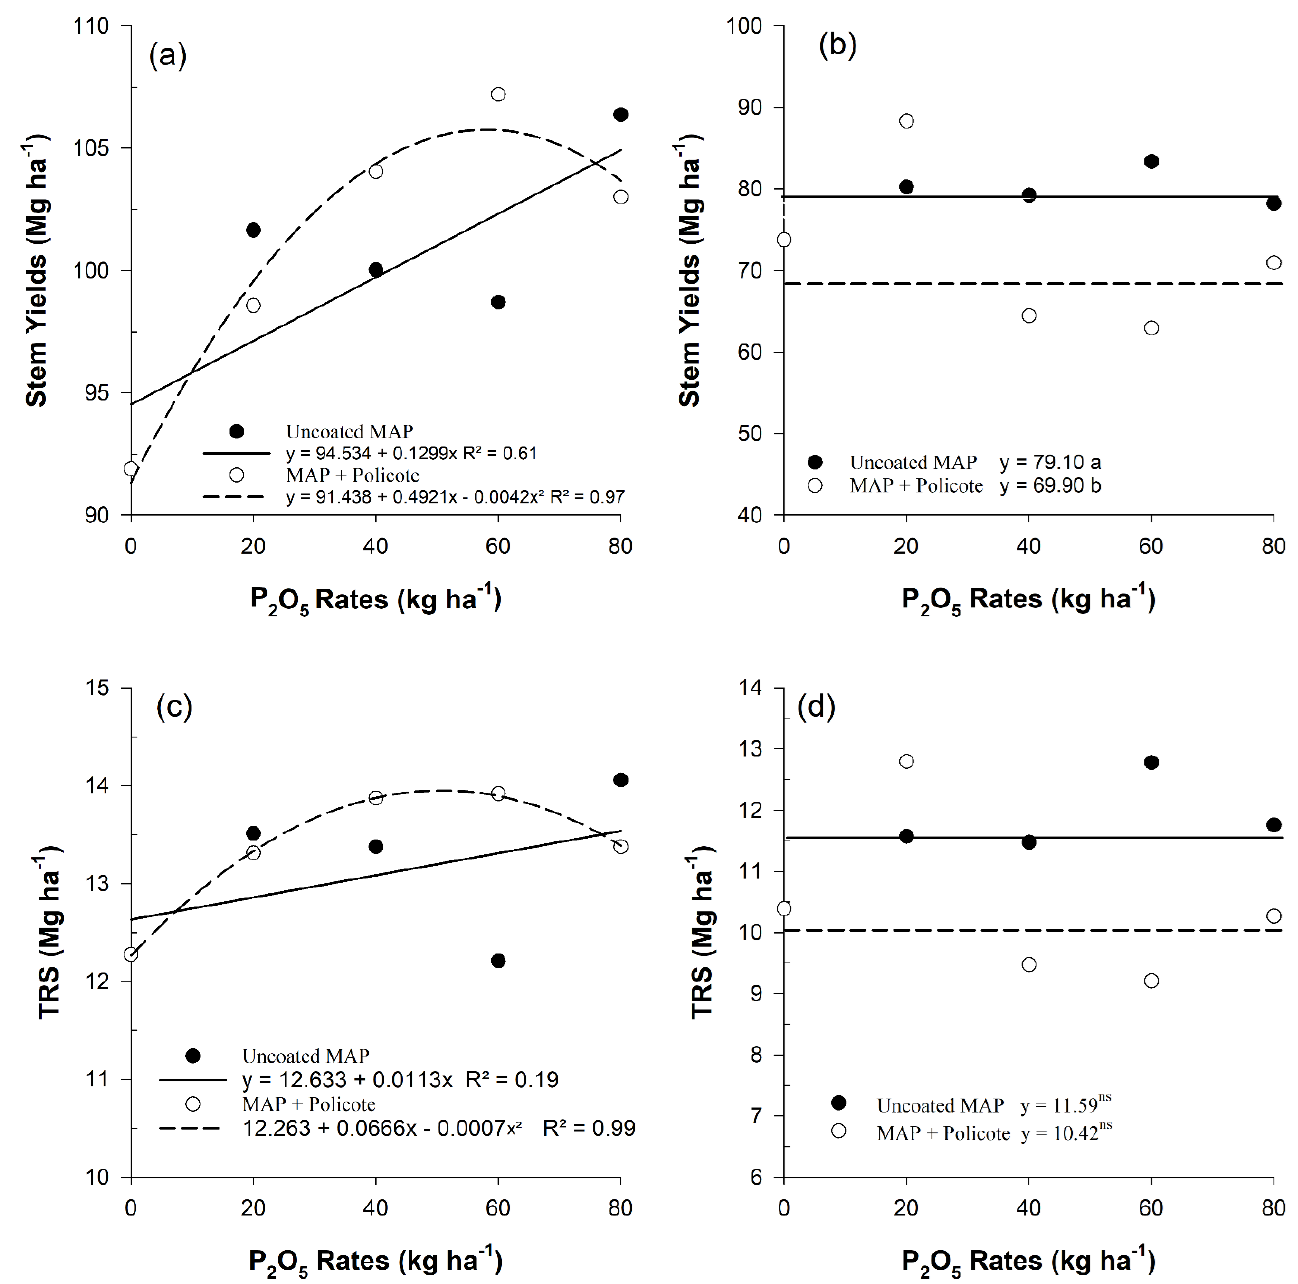
Figure 4. Stalks and TRS yield in the second ratoon ( a , c ) and in the third ratoon crop ( b , d ) of sugarcane fertilized with phosphorus rates and sources without or with Policote coating in two sugarcane production cycles. Growing seasons 2018/2019 and 2019/2020. Different letters indicate significant differences according to Tukey’s test ( p < 0.05), ns — p >